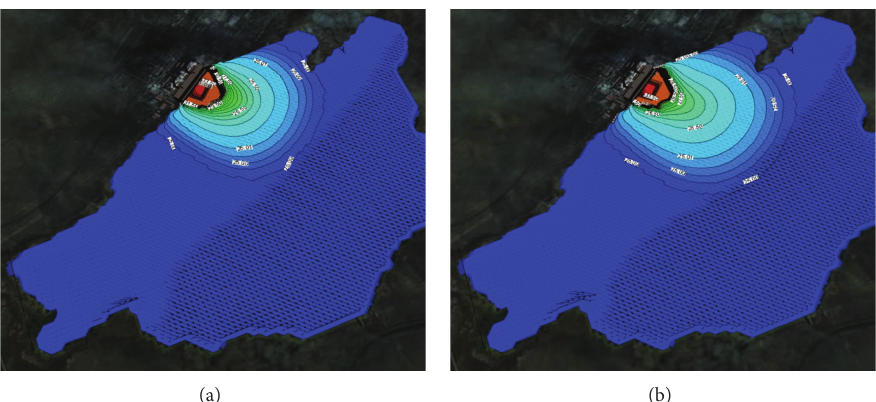
Figure 5: Outline and contours of temperature at 15 and 24 hours at the north-west wind after the launch of Ekibastuz SDPP-1 on the surface and the top view.